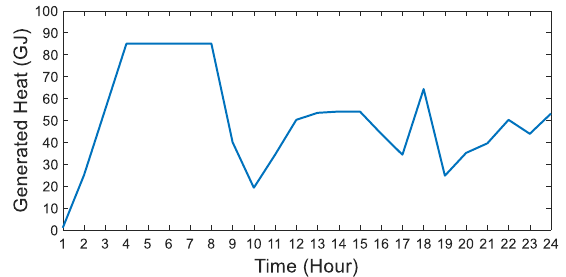
Figure 11. Optimized steam generation of the industrial boiler.